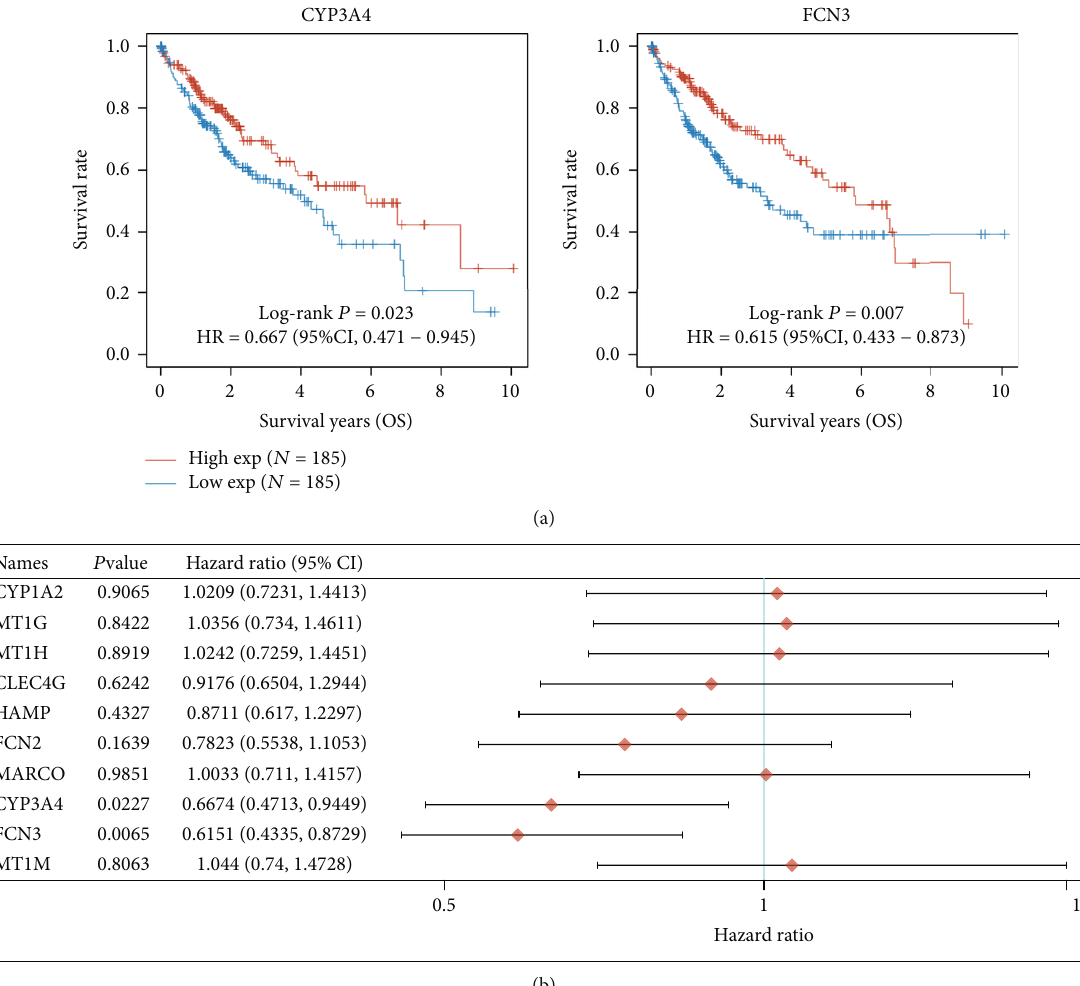
Figure 5: Identi fi cation of total genes having a correlation with survival in HCC using the top 10 reduced genes.(a) Patients with high expression of CYP3A4 and FCN3 showed a longer total survival as compared with those having low expressions of CYP3A4 and FCN3. (b) Univariate Cox regression